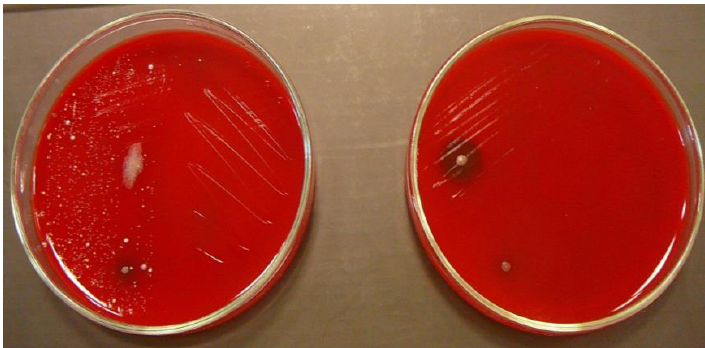
Figure 2. Blood agar with bacteria isolated from keyboards before ( left ) and after ( right ) disinfection.